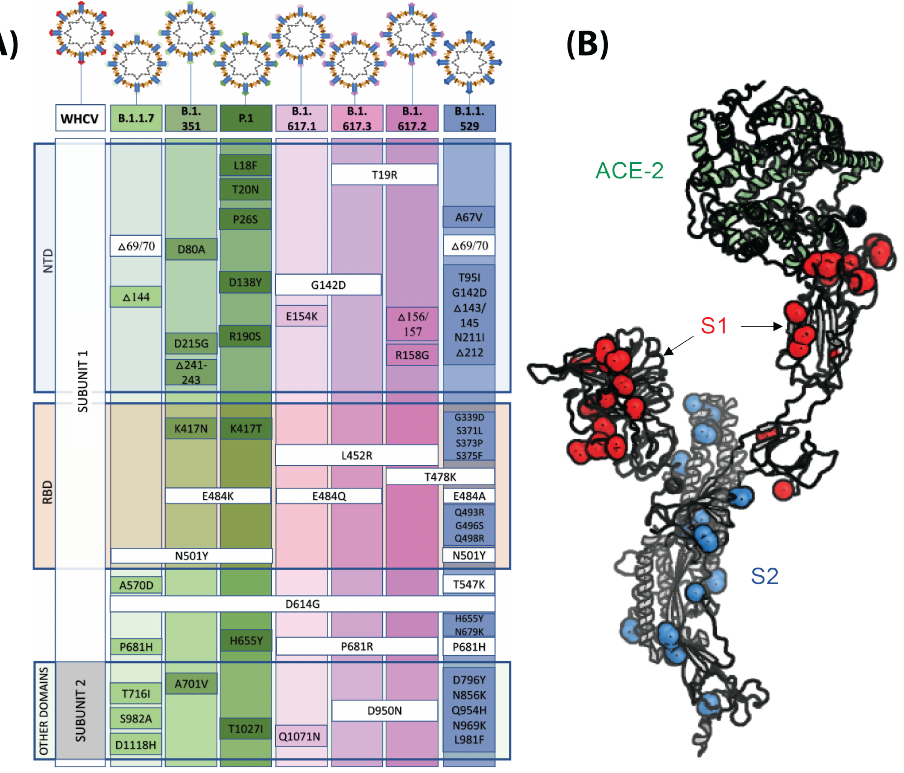
Figure 4. ( A ) observed mutations in the spike protein among variants of concern in SARS-CoV-2. ( B ) Structural location of these variants. The spheres indicate the locations of observed mutations in either S1 or S2 subdomain